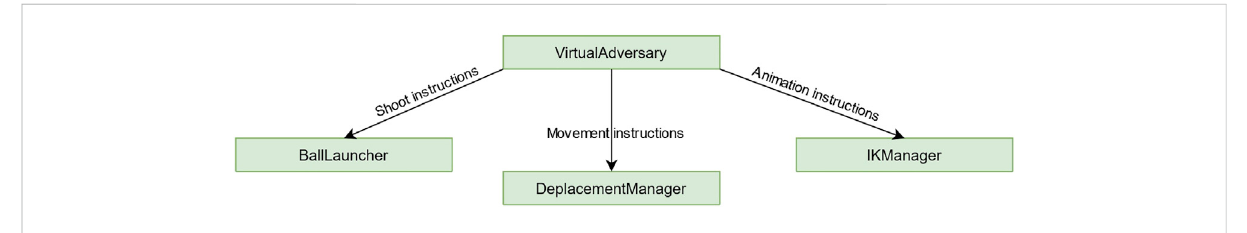
FIGURE 11 Simpli fi ed UML diagram of project scripts.